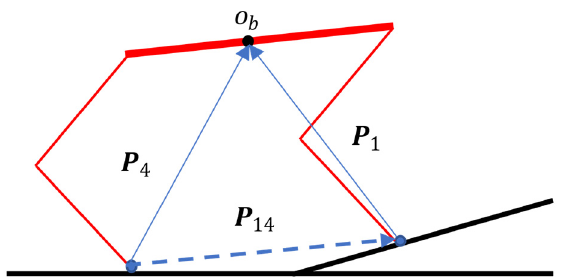
Figure 4. Schematic diagram of quadruped slope walking.